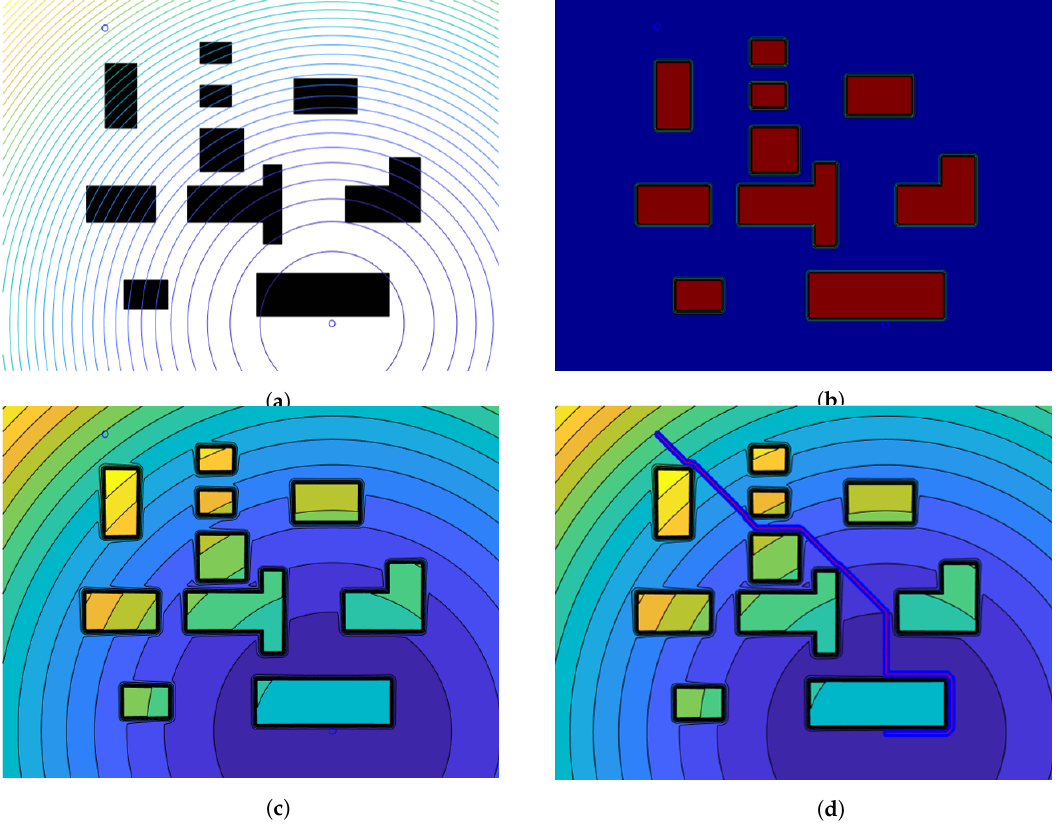
Figure 13. Artificial Potential Field (APF) based path planning results: ( a ) Attractive potential ( b ) Repulsive potential ( c ) Potential field ( d ) APF based